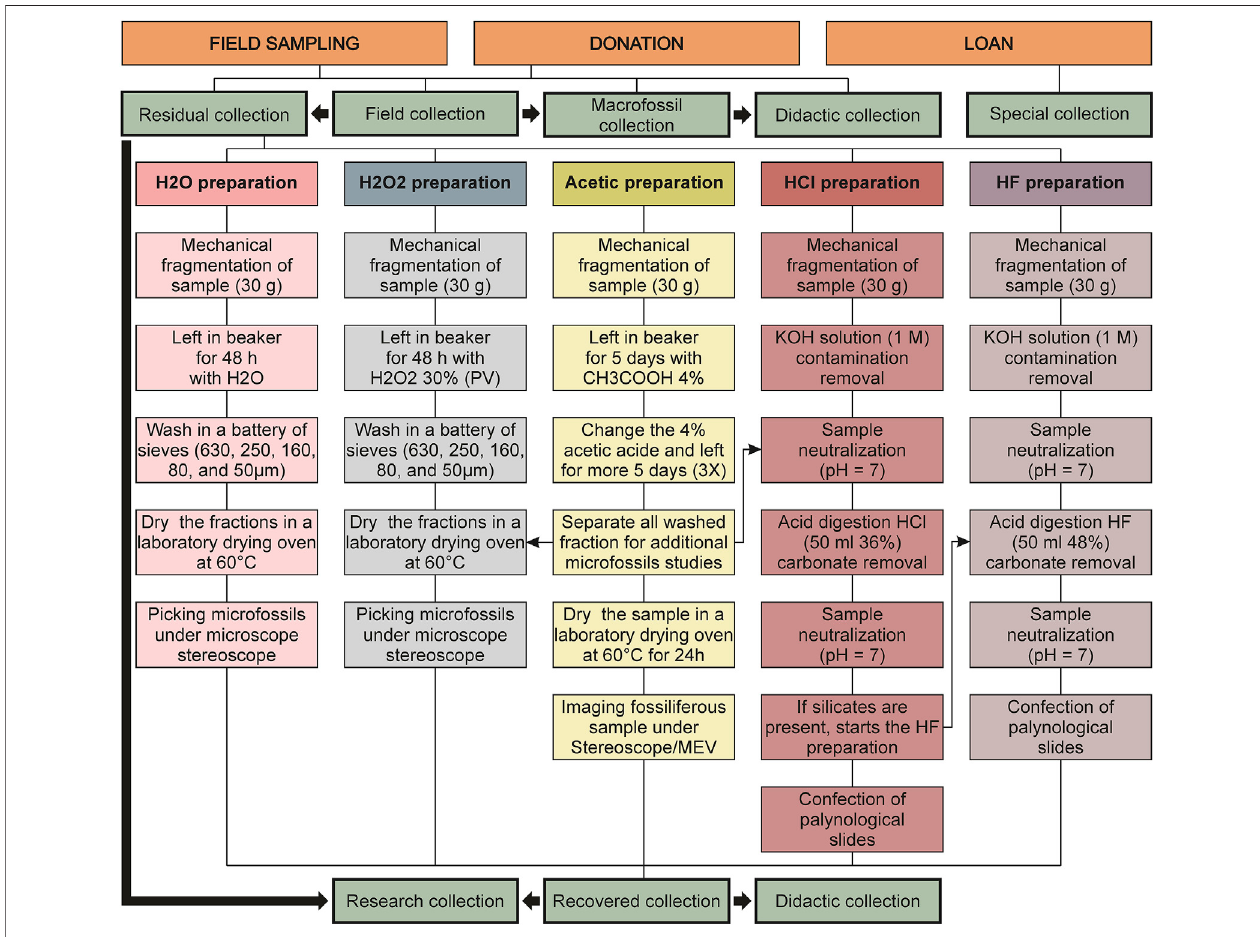
FIGURE 6 | Flowchart of curatorship management and sample preparations of the Laboratory of Micropaleontology, University of Brasília. The great black arrows indicate the possibilities of relocation of samples.